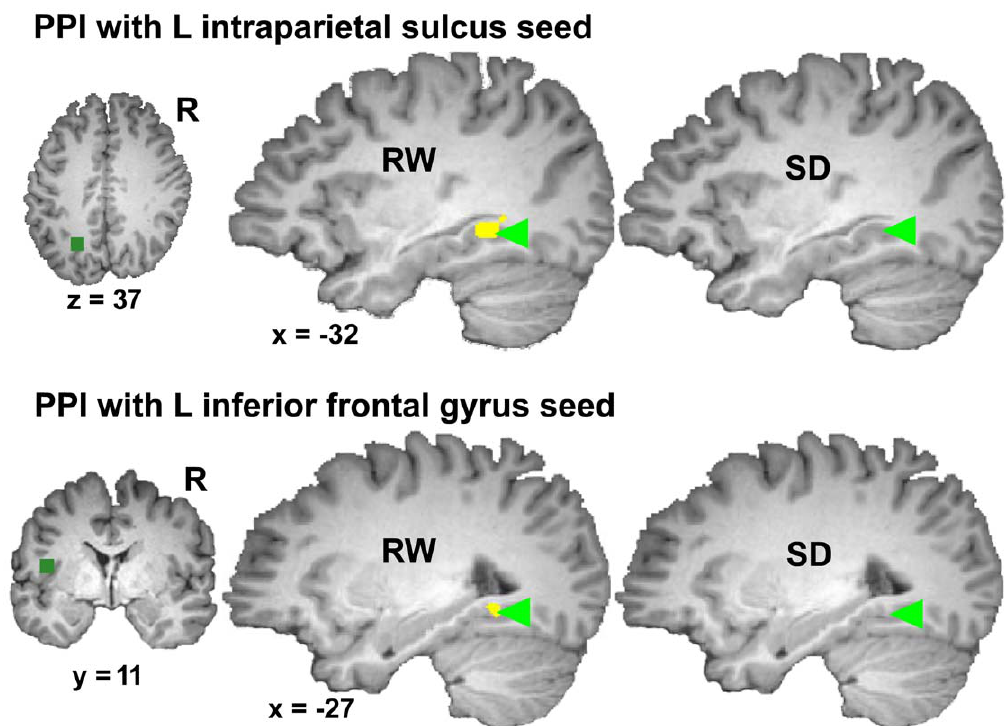
Figure 6. Psychophysiological interaction (PPI) in the rested and sleep deprived state. Connectivity analysis was performed using seeds in the left intraparietal sulcus (IPS; Talairach co-ordinates: 2 27, 2 58, 37) and left inferior frontal regions (Talairach co-ordinates: 2 36, 11, 4) (seed regions represented by green squares). Each map represents the conjunction of regions showing significant PPI in the Attend House (AH) vs. Ignore House (IH) and AH vs. Observe House (OH) conditions (threshold p , .05). 37) and left inferior frontal regions (bottom panel: Talairach co- ordinates: 2 36, 11, 4). Each map represents regions showing significant PPI in the AH vs. IH and AH vs. OH conditions (threshold p , .05) and in each state (RW, SD). Found at: doi:10.1371/journal.pone.0009087.s002 (0.42 MB TIF)